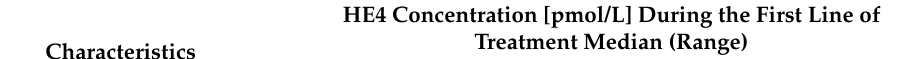
Table 2. Comparison of HE4 serum concentrations during the first line of treatment between the patients that developed and did not develop OC recurrence during the study period.